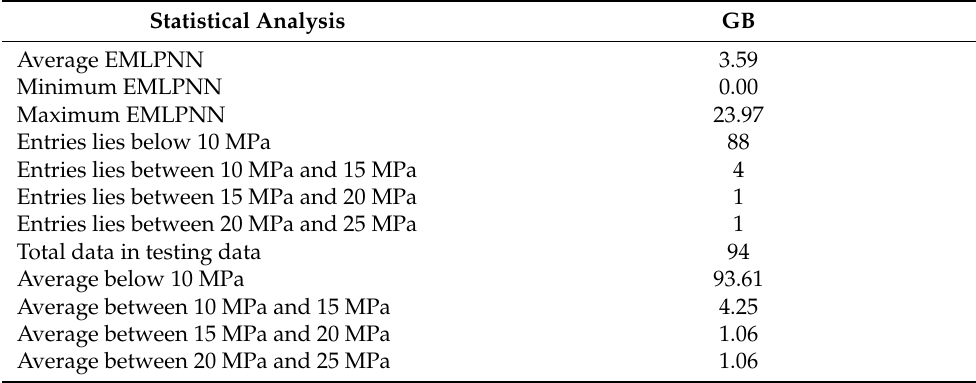
Figure 12. ( a ) Prediction vs targets of GB; ( b ) Distribution of errors of GB model. Table 9. Statistical analysis of